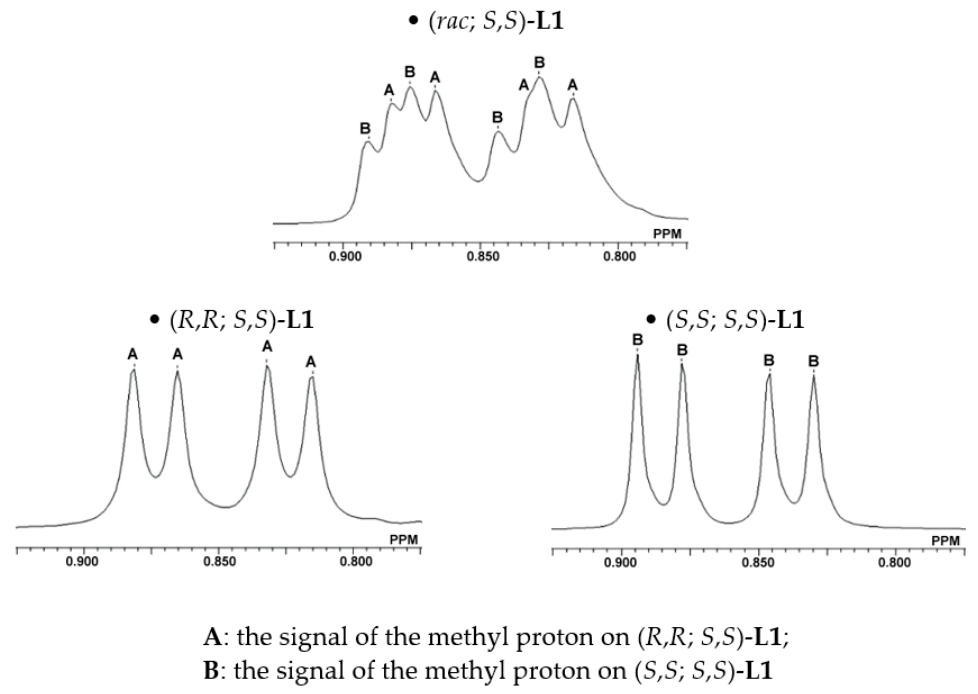
Figure 3. 1 H NMR spectrum of the methyl proton on selected L1 (at 80 °C).